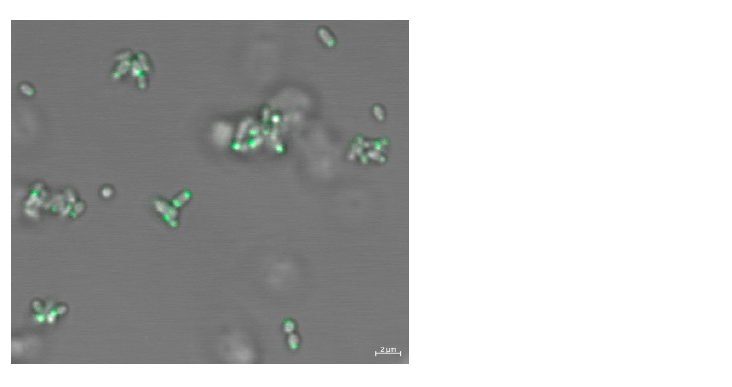
Figure 6. Cellular localization of MCP 514 in CheW-deficient A. fabrum mutant. Plasmid expressing eGFP-MCP 514 fusion protein was introduced into the atu051–cheW 1 –cheW 2 triple-deletion mutant Δ 514 Δ w . Cells were grown to the middle-log phase and observed by using confocal laser-scanning microscopy.